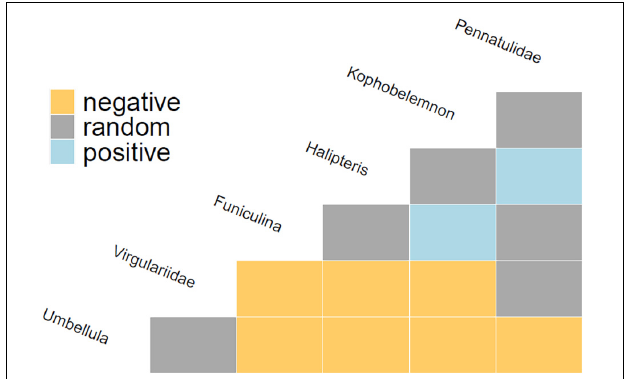
FIGURE 3 | Taxon co-occurrence matrix output from the co-occur package in R. This shows comparisons of observed and expected frequencies of taxon co-occurrence based on Veech (2013) probabilistic model of species co-occurrence. Positive patterns suggest a high likelihood of co-occurrence, while negative have a low likelihood of co-occurrence, and random show no discernible